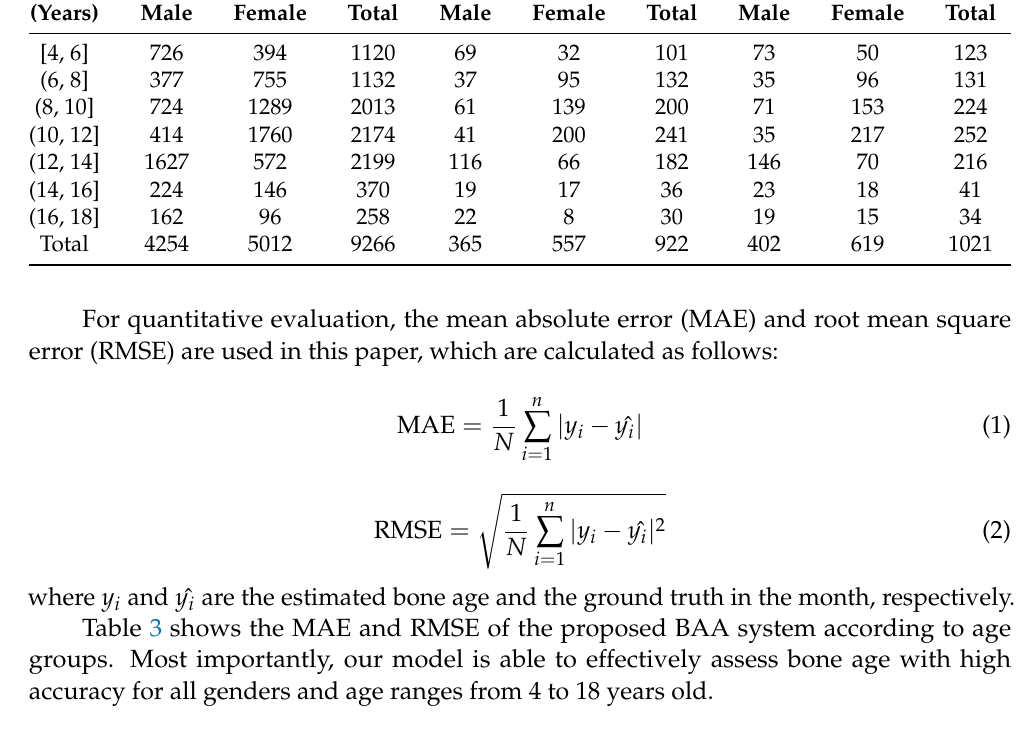
Table 3. Bone age prediction accuracy per age